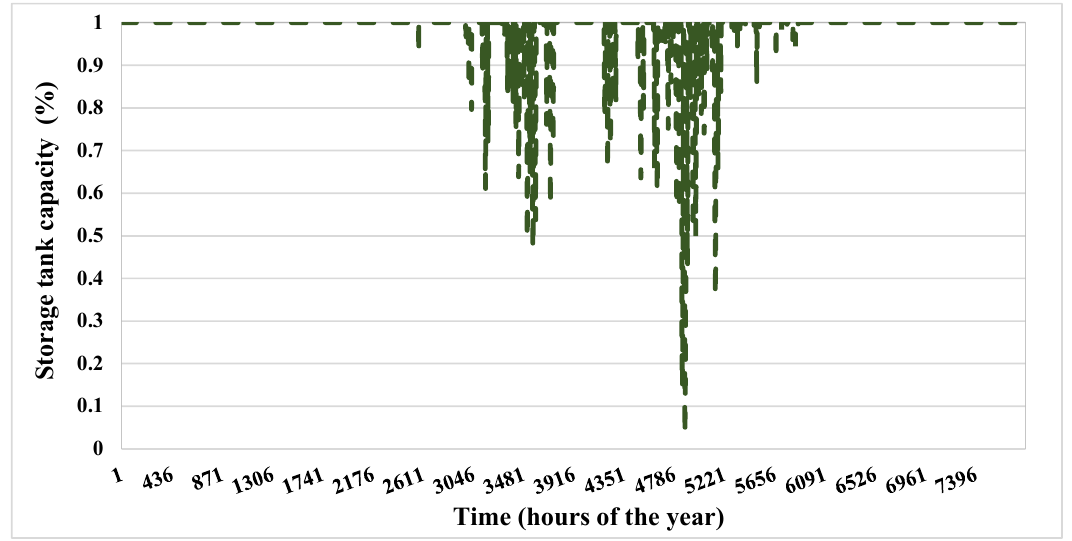
Figure 11. Charging level of the storage tank during the warm months of the year.